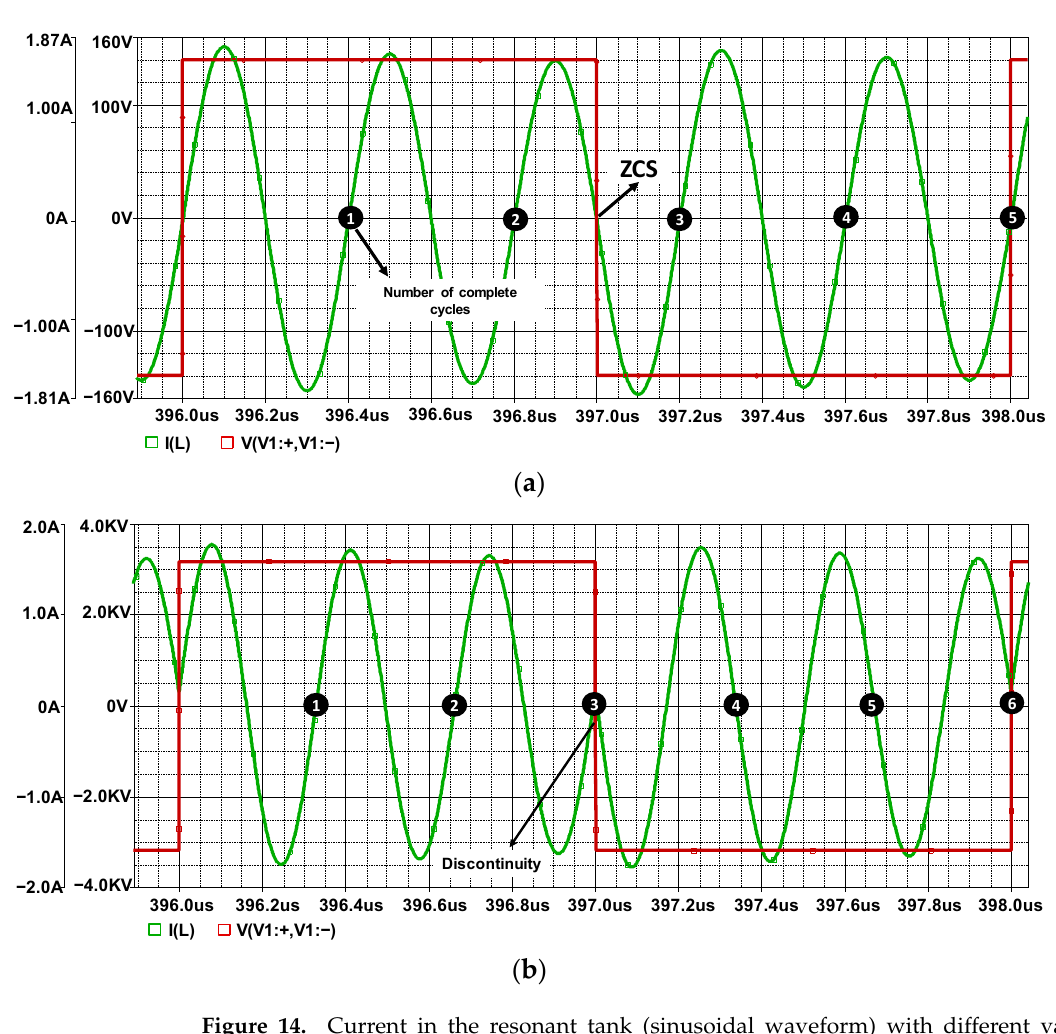
Figure 14. Current in the resonant tank (sinusoidal waveform) with different values of “ n ”. ( a ) Current in the resonant tank with an odd value of “ n = 5” and ZCS. ( b ) Current in the resonant tank with an even value of “ n = 6”.